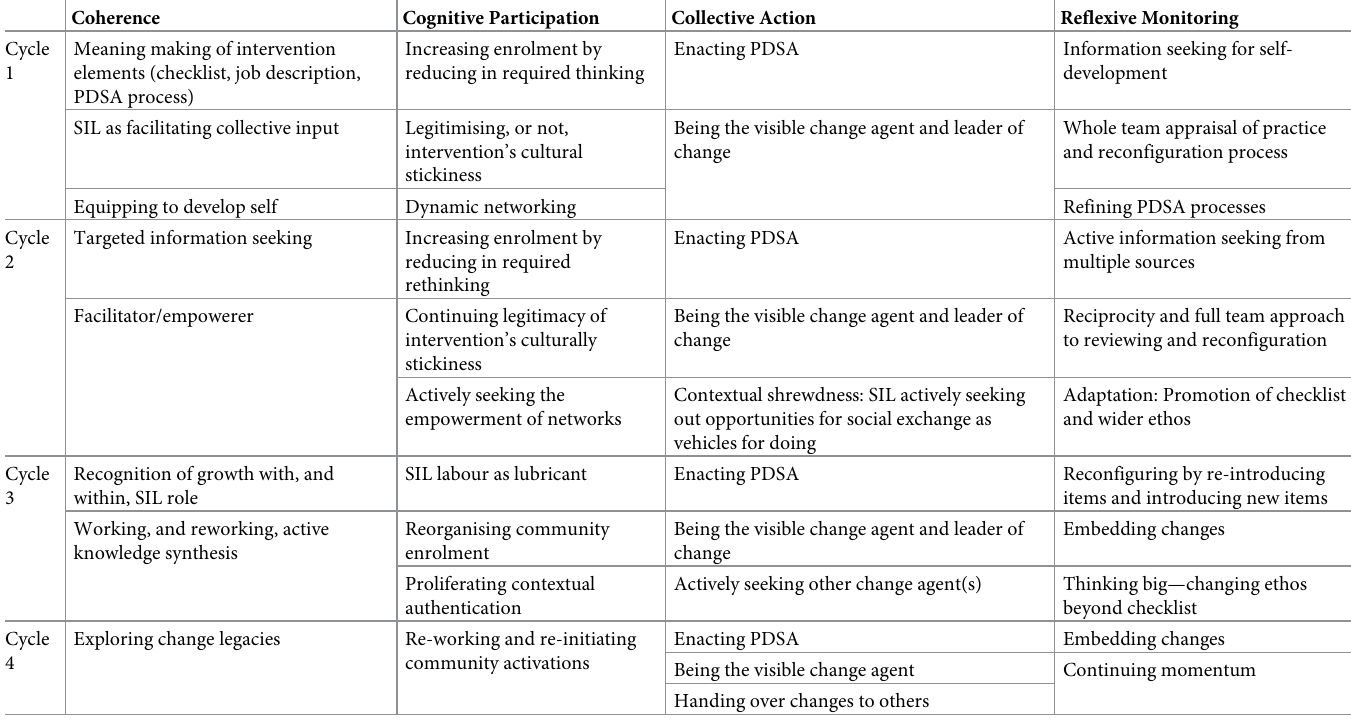
Table 3. Normalisation process at SITE